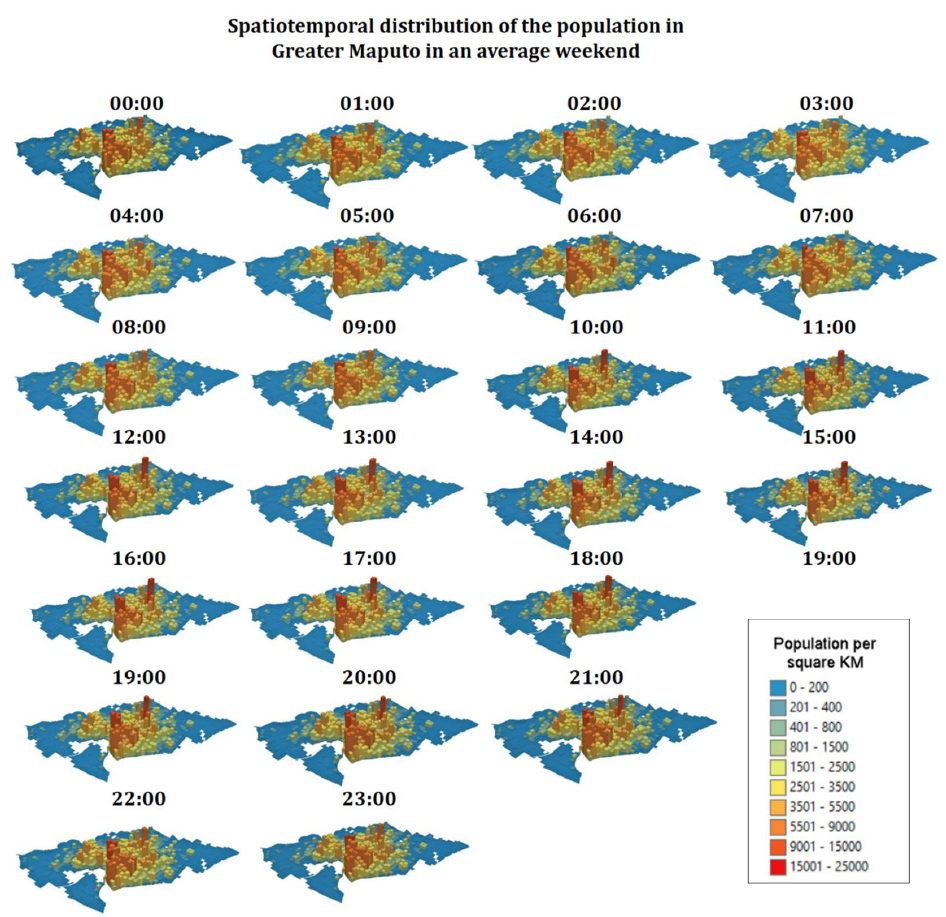
Figure 19. Spatiotemporal distribution of the population in Greater Maputo on an average weekend.